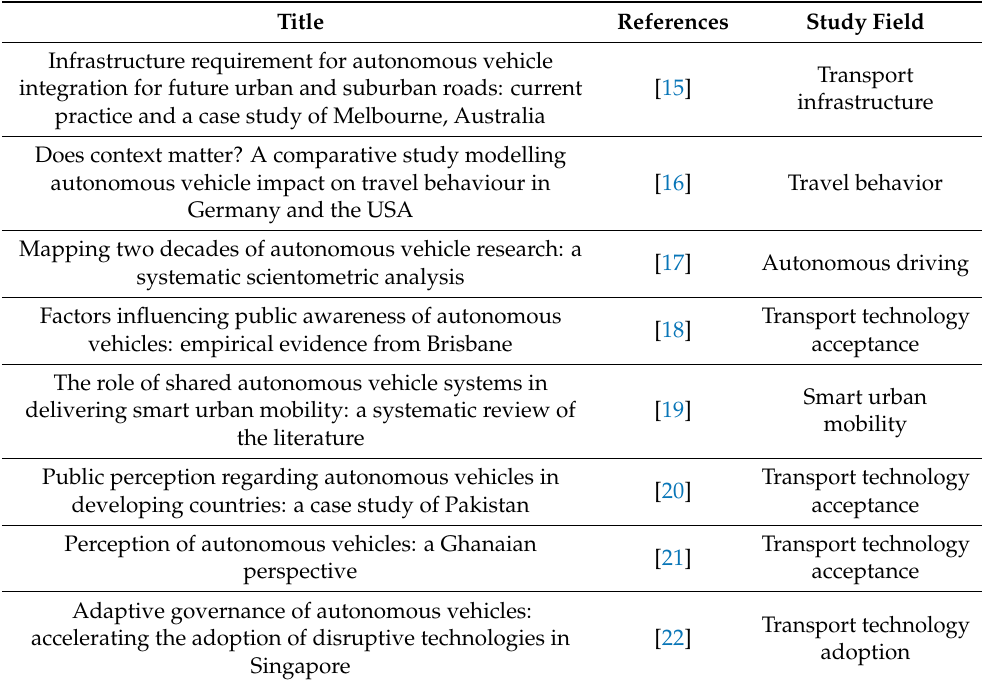
Table 1. A summary of the background